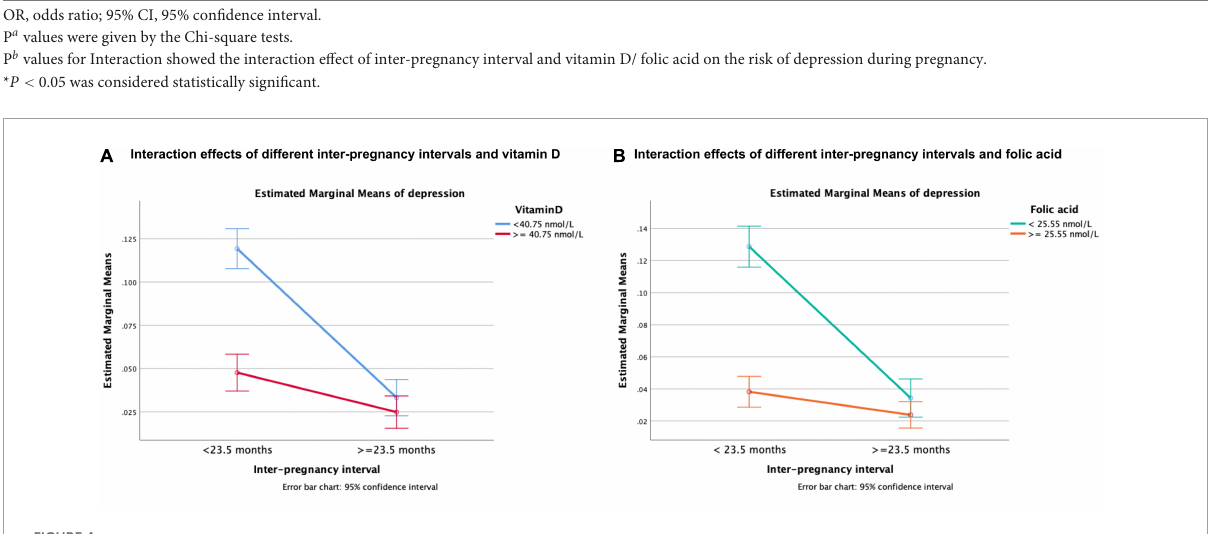
FIGURE4 Interaction effects of different IPIs and vitamin D/folic acid levels on the risk of third-trimester depression. (A) Interaction effects of different inter-pregnancy intervals and vitamin D. (B) Interaction effects of different inter-pregnancy intervals and folic